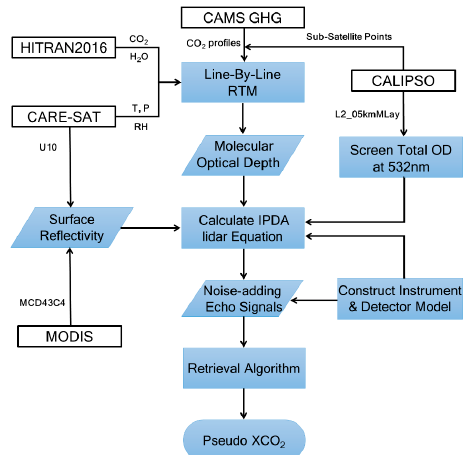
Figure 1. Flowchart for data processing and model simulation to evaluate the performance of AC ‐ IPDA lidar.